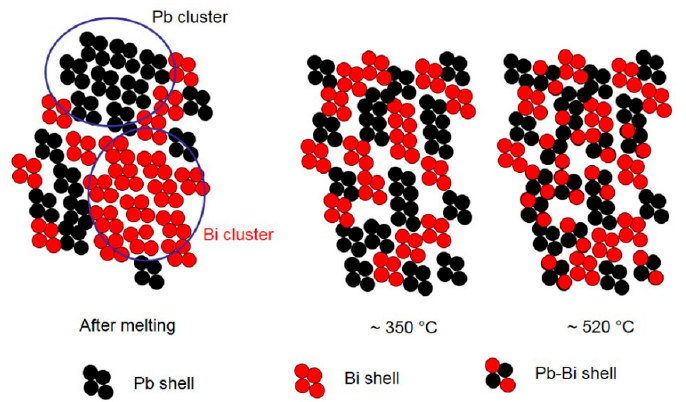
Figure 13. Schematic view of the atomic and micro-scale transformations occurring in liquid LBE alloy at increasing temperature.